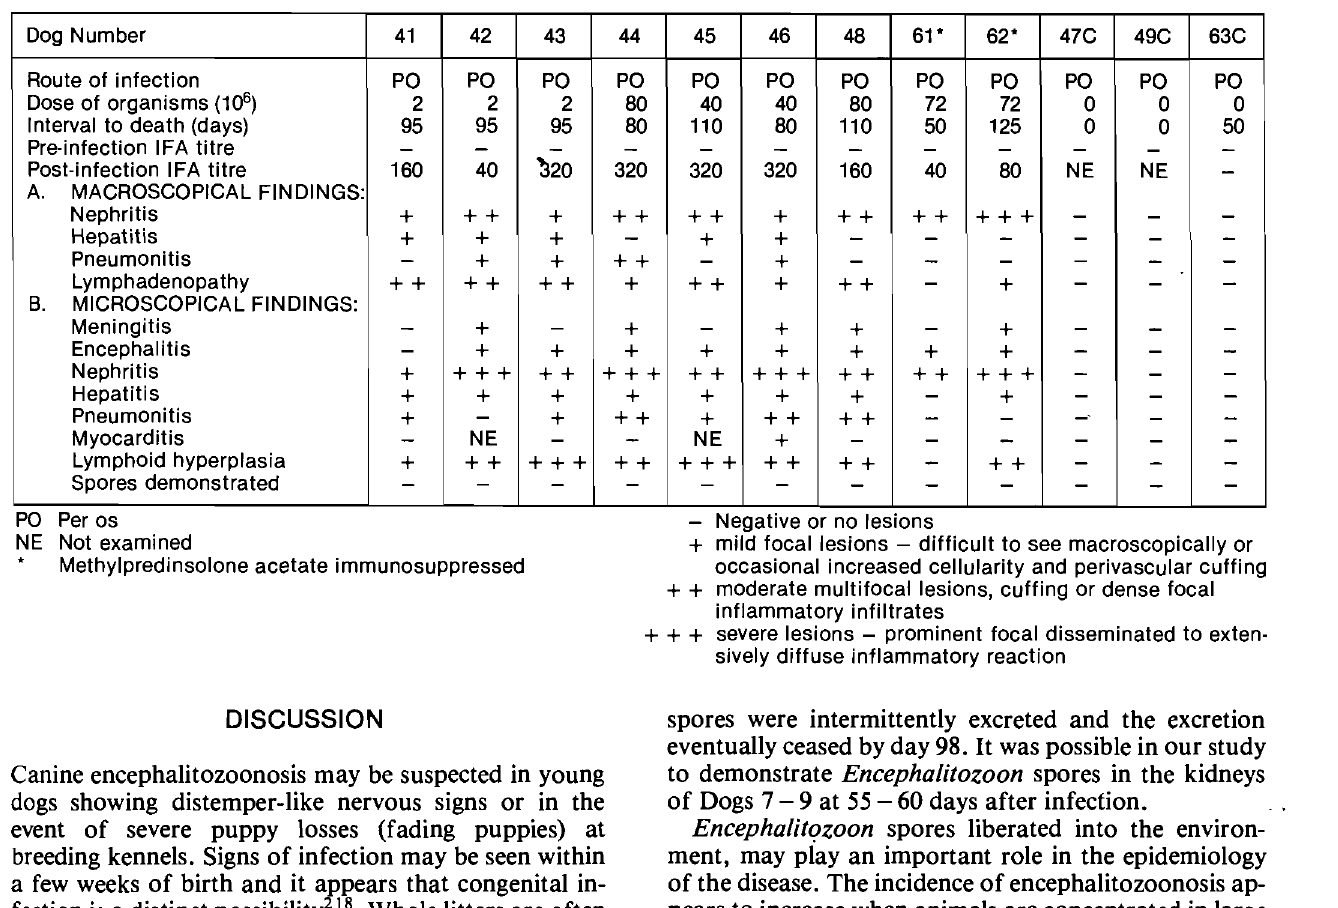
Table 4: Experiment 4 - Oral dosing of Encephalitozoon